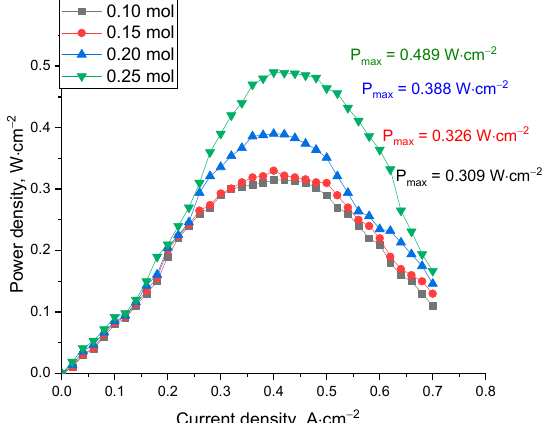
Figure 7. Electrochemical characteristics: current density–specific power (I–P) characteristic curves. As can be seen from the data presented, the maximum value of specific power is achieved at an open circuit voltage of approximately 1.1–1.15 V; it varies from 0.309 W ∙ cm − 2 to 0.489 W ∙ cm − 2 depending on the phase composition of the ceramics. At the same time, in the case when the (La 0.3 Sr 0.7 ) 2 FeO 4 phase dominates in the composition of the ce ‐ ramics, the power value changes insignificantly from 0.309 to 0.326 W ∙ cm − 2 with a de ‐ crease in the LaSr 2 Fe 3 O 8 phase contribution from 31 to 22%. Formation of the Sr 2 Fe 2 O 5 phase in the composition of ceramics leads to an increase in P max to 0.388 W ∙ cm − 2 , and subsequent displacement of the LaSr 2 Fe 3 O 8 phase leads to an increase in P max to 0.489 W ∙ cm − 2 ,